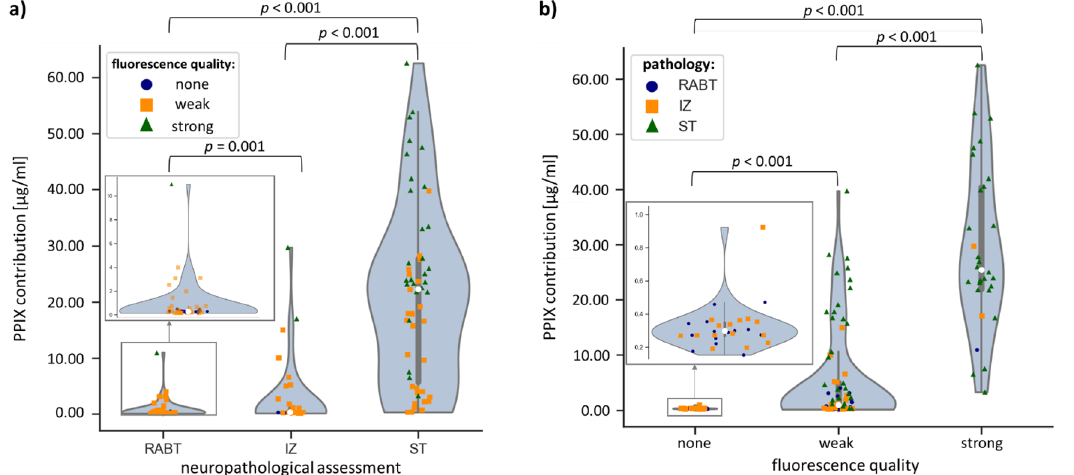
Figure 8. PPIX contributions in the cohort of 240 samples. ( a ) neuropathological grouping and ( b ) groups according to the quality of fluorescence as observed with the surgical microscope. Inside the violin graphs, bars show the interquartile range (IQR), whiskers represent 1.5-fold IQR, the white dot is the median of the